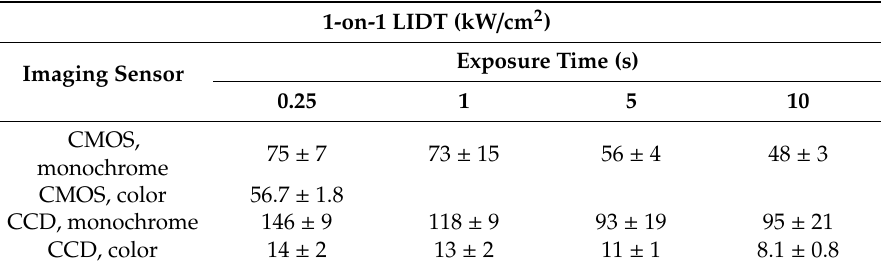
Table 4. 1-on-1 Laser induced damage threshold (LIDT) measured for some specific imaging sensors (CCD: Sony ICX098, CMOS: Aptina MT9V024) [28]. 1-on-1 LIDT (kW / cm 2